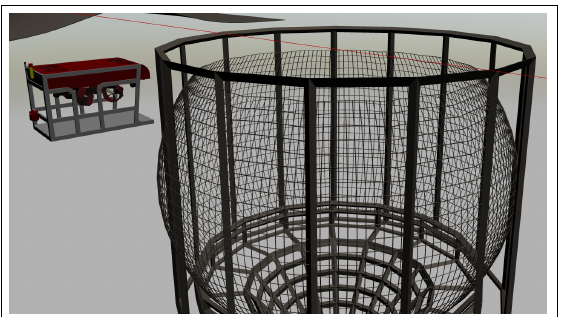
Figure 10. Simulation setup. Model initialized in Gazebo